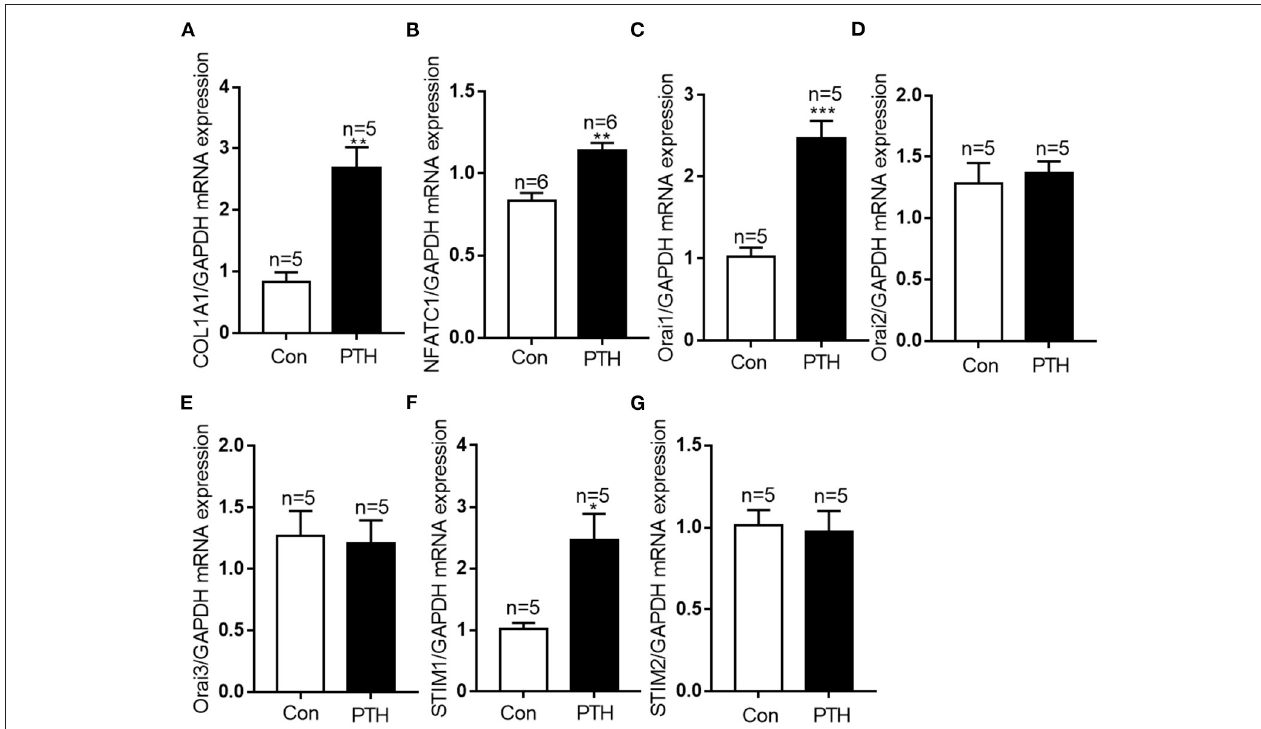
FIGURE 5 | Effect of parathyroid hormone (PTH) on mRNA expressions of COL1A1, NFATC1, Orai1, Orai2, Orai3, STIM1 and STIM2 in human umbilical vein endothelial cells (HUVECs). (A–G) After the treatment with vehicle control or 100 pM PTH for 24h, alterations in (A) COL1A1 , (B) NFATC1 , (C) Orai1 , (D) Orai2 , (E) Orai3 , (F) STIM1 , (G) STIM2 mRNA levels were detected by qPCR assays in HUVECs. Messenger RNA expression was normalized to that of GAPDH. Data are shown as the mean ± SEM; n = 5 – 6. * P < 0.05, ** P < 0.01, *** P < 0.001 vs.